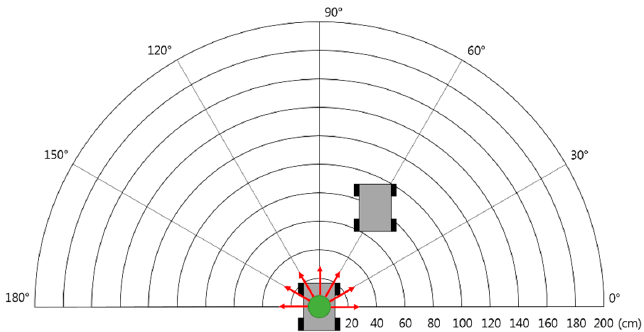
Figure 18. Environment for accuracy evaluation of relative-location estimation using IR communication.